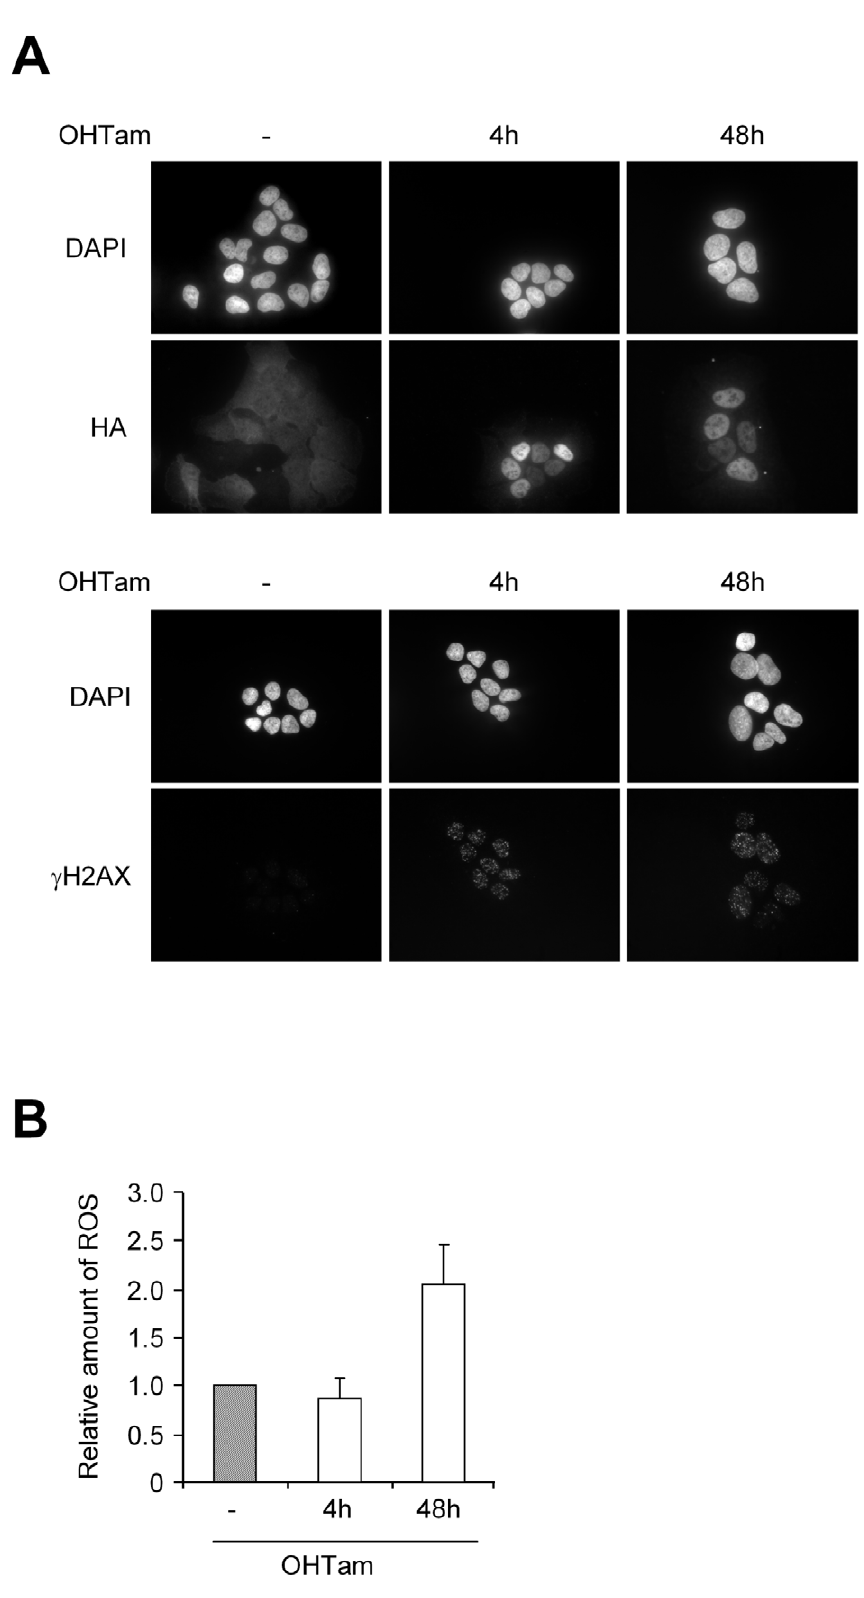
Figure 6. Persistent DNA breaks are sufficient to induce oxidative stress. (A) U2OS HA-AsiSI-ER cells were treated with OHTam for 4 h or 48 hours, or not, as indicated. Cells were then fixed and subjected to DAPI staining and immunofluorescence using anti-HA (top panels) and anti- c H2AX (bottom panel) antibodies. (B) Same as in (A) except that ROS levels were measured by flow cytometry. The mean and SD from 3 independent experiments are shown (after standardisation relative to 1 for cells untreated with OHTam).